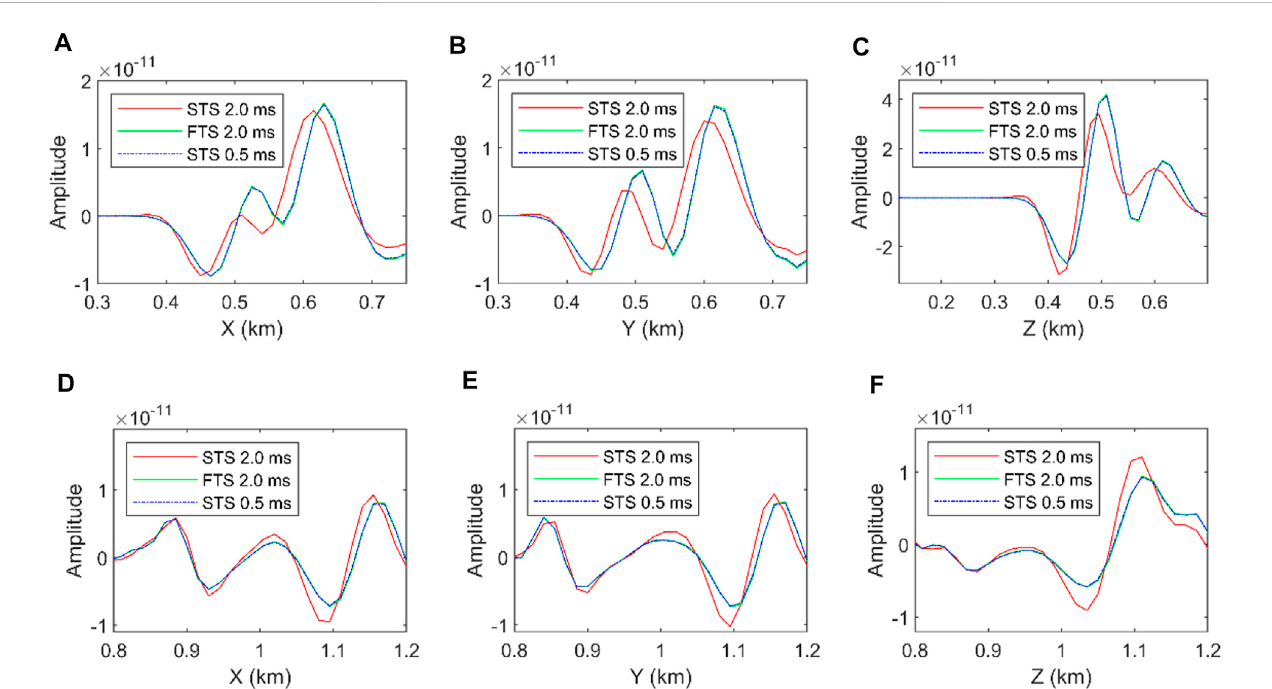
FIGURE 8 Pro fi le comparisons at the positions of (A) and (D) ( y , z ) = (1.2, 1.2) km, (B) and (E) ( x , z ) = (1.2, 1.2) km, and (C) and (F) ( x , y ) = (1.2, 1.2) km. (A-C) are the P-wave fi eld results from the STS and FTS methods, and (D-F) are the S-wave fi eld results from the STS and FTS methods.